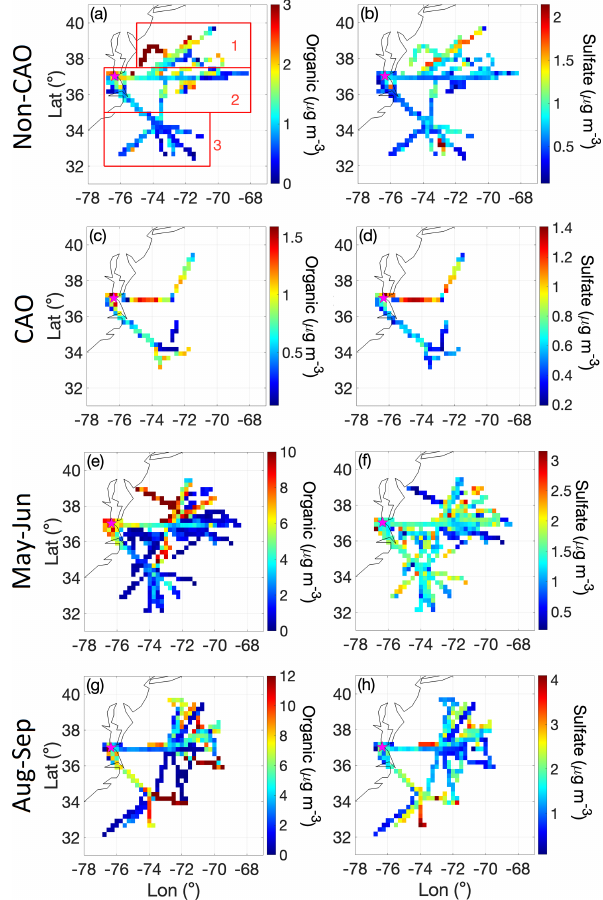
Figure 2. Spatial map of cloud-free AMS data for organics and sulfate collected during deployments 1–4 of ACTIVATE spanning from February 2020 to June 2021. Non-CAO and CAO represent non-cold air outbreak and cold air outbreak days, respectively, be- tween January and March. Spatial boxes labeled 1–3 in (a) corre- spond to domains used for calculations in other parts of this study. Grid cells are 0.25 ◦ × 0.25 ◦ and represent an average of data across all vertical levels flown between 0.02 and 8.1km. Color bar scales differ by panel to highlight variability better within a